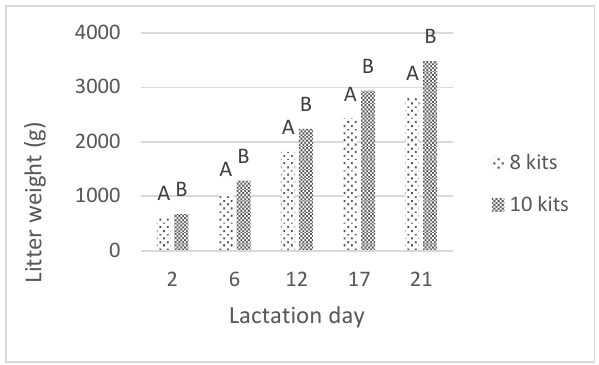
Figure 1. The effect of litter size on litter weight (A, B—means marked with different letters differ significantly at p < 0.01).